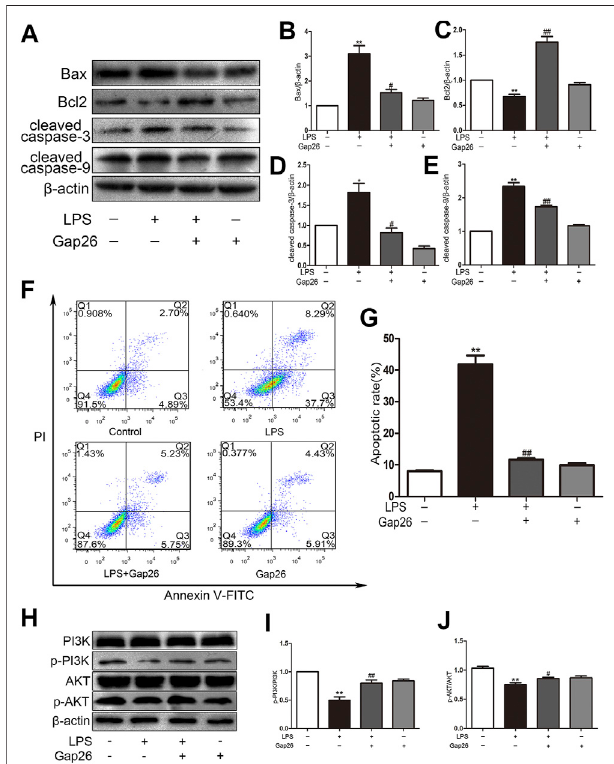
FIGURE 3 | Gap26 reverses LPS-induced apoptosis and activates the PI3K/AKTsignallingpathway. (A) TheeffectsofLPSandGap26onBax,Bcl2, cleaved caspase-3 and cleaved caspase-9 protein levels. (B – E) Statistical analysis. (F) The rate of apoptosis after treatment with Gap26 and LPS. (G) Statistical analysis. (H) The effects of LPS and Gap26 on PI3K, p-PI3K, AKT, and p-AKT proteins. (I – J) Statistical analysis (* p < 0.05, ** p < 0.01 vs. control, # p < 0.05, ## p < 0.01 vs. the LPS group. The data are shown as the means ± SEs (n (cid:2)